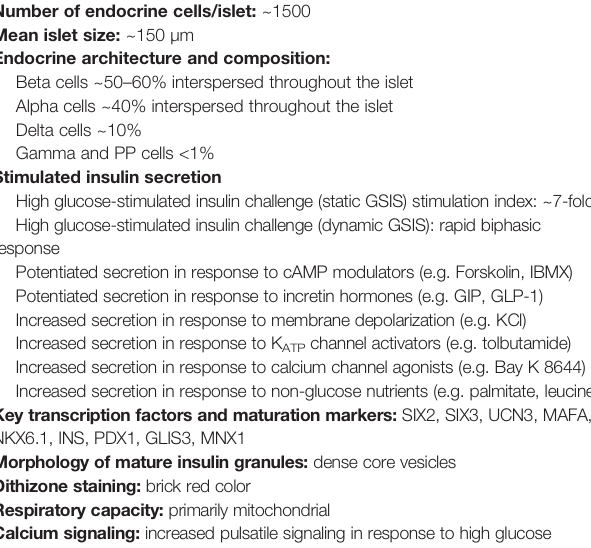
TABLE 2 | Key characteristics of human islets. Morphology: spheroid Number of endocrine cells/islet: ~1500 Mean islet size: ~150 µm Endocrine architecture and